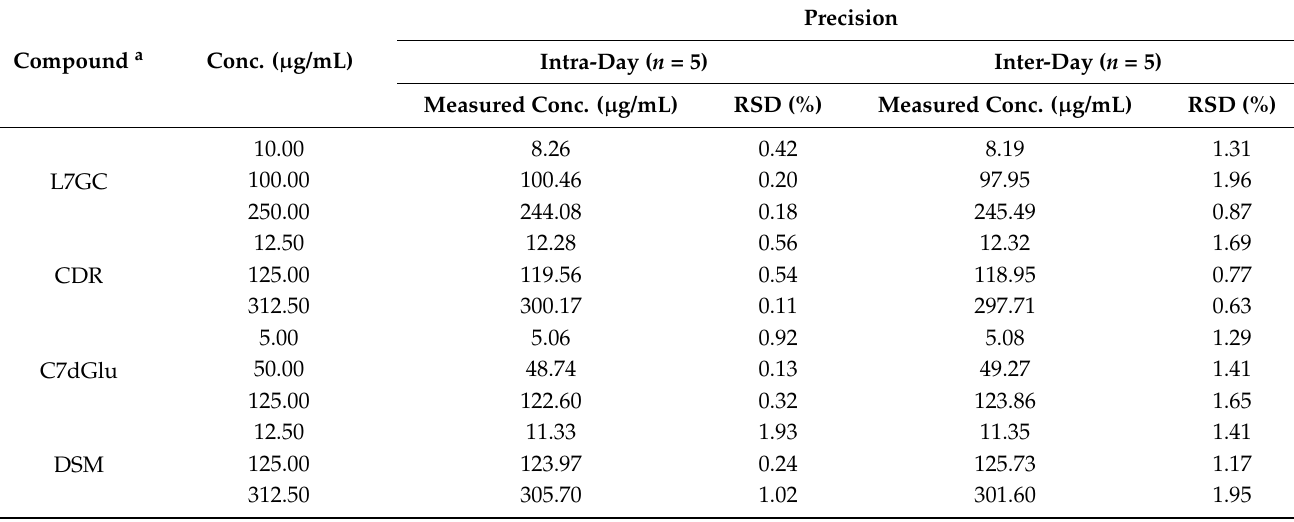
Table 2. Inter- and intra-day precision of L7GC, CDR, C7dGlu, and DSM at low, medium, and high concentrations for the developed HPLC-PDA